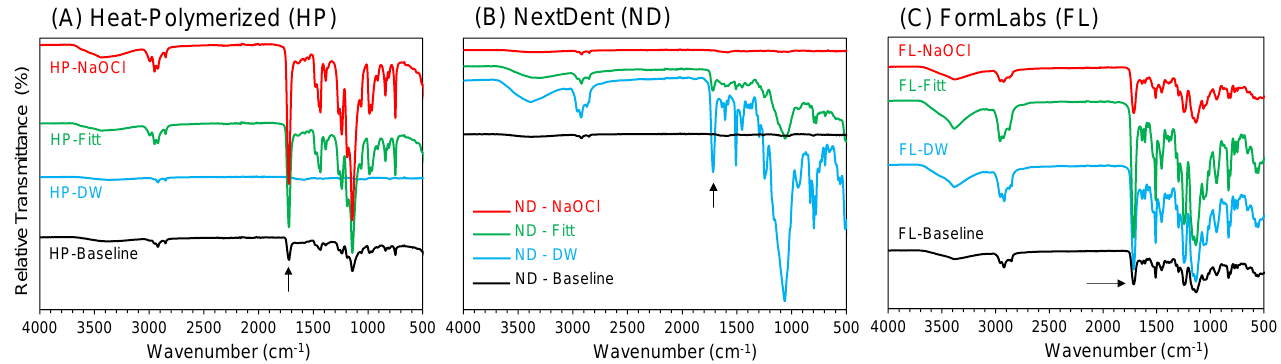
Figure 1. FTIR spectra of the three groups of specimens disinfected with DW, effervescent tablets, and NaOCl. ( A ) HP resin, ( B ) ND, and ( C ) FL. The baseline FTIR spectrum of the specimens is also shown. Fitt, effervescent tablets.